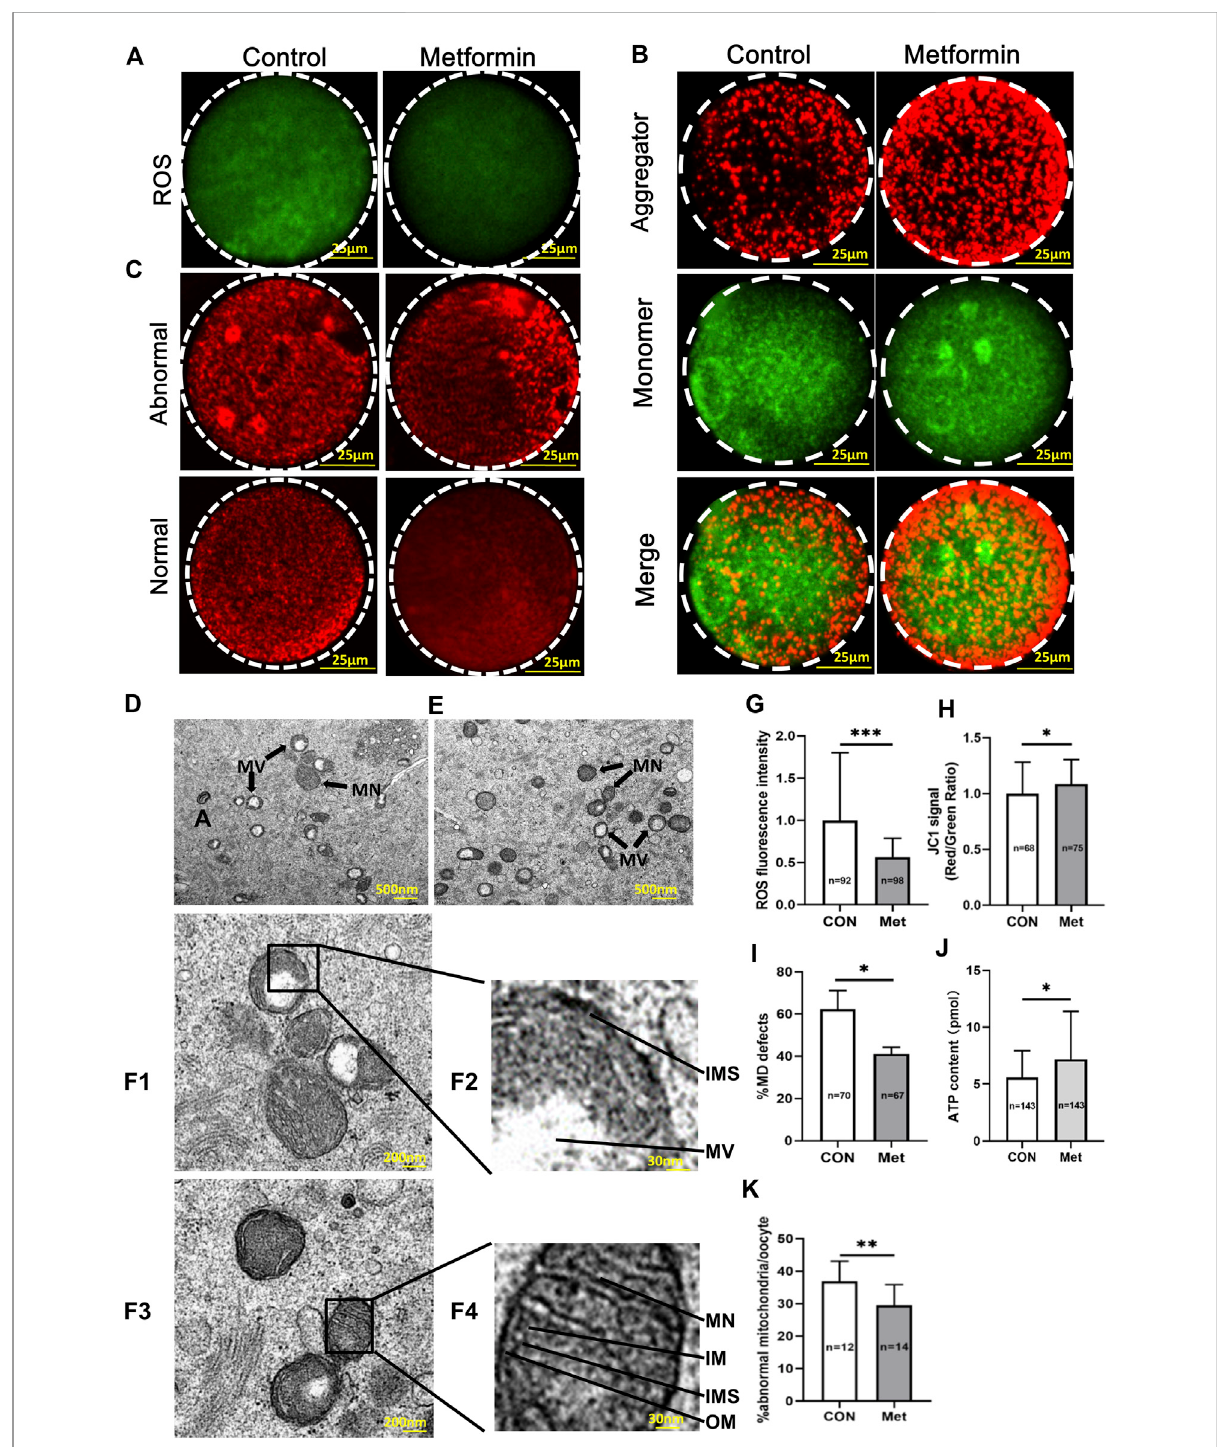
FIGURE 4 Metformin reduces ROS, attenuates mitochondrial function, and improves mitochondrial ultrastructure of oocytes from aged mice. (A) Representative images of staining for ROS using carboxy-H2DCF diacetate fl uorescence (green) in M Ⅱ stage oocytes after IVM with or without metformin treatment. Scale bar, 100 μ m. (B) JC-1 staining shows the mitochondrial membrane potential (MMP), for oocytes treated in control and metformin-treated oocytes. Note that the same oocytes were observed in both the TRITC channel (red fl uorescence) and the FITC channel (green fl uorescence). Scale bar, 25 μ m. (C) Distribution of mitochondria, as stained using MitoTracker-Red in oocytes treated with or without metformin. Scale bar, 25 μ m. (D) Representative transmission electron microscopy (TEM) micrographs of mitochondria from control oocytes.